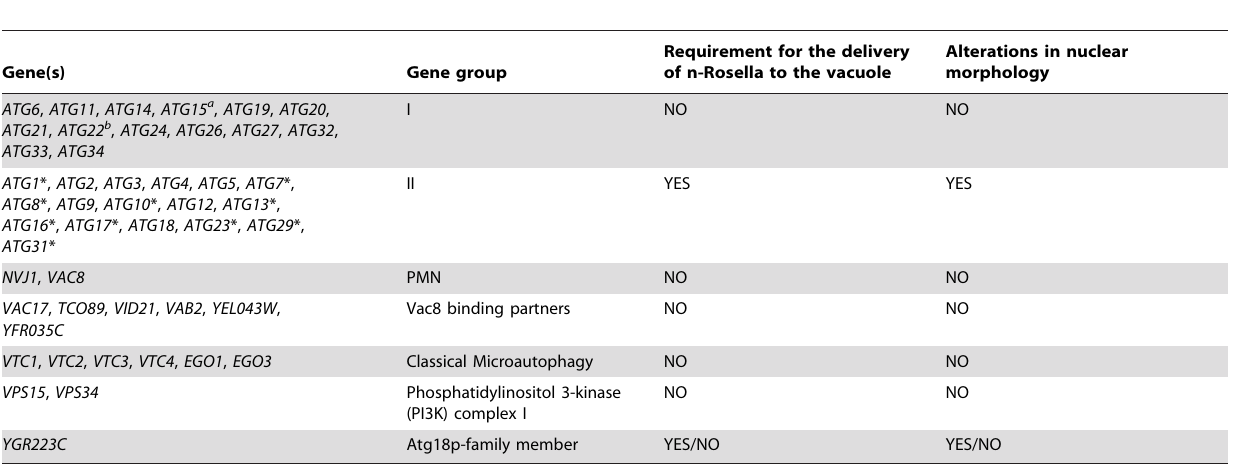
Table 1. The requirement for different ATG and non- ATG genes on the degradation of the nucleus and nuclear morphology during